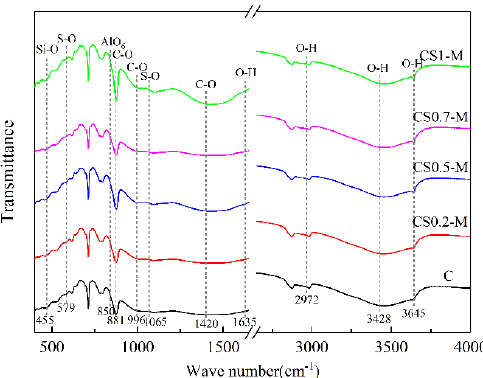
Figure 8. Infrared spectroscopy of concrete after erosion in NaCl-MgSO 4 composite solution.